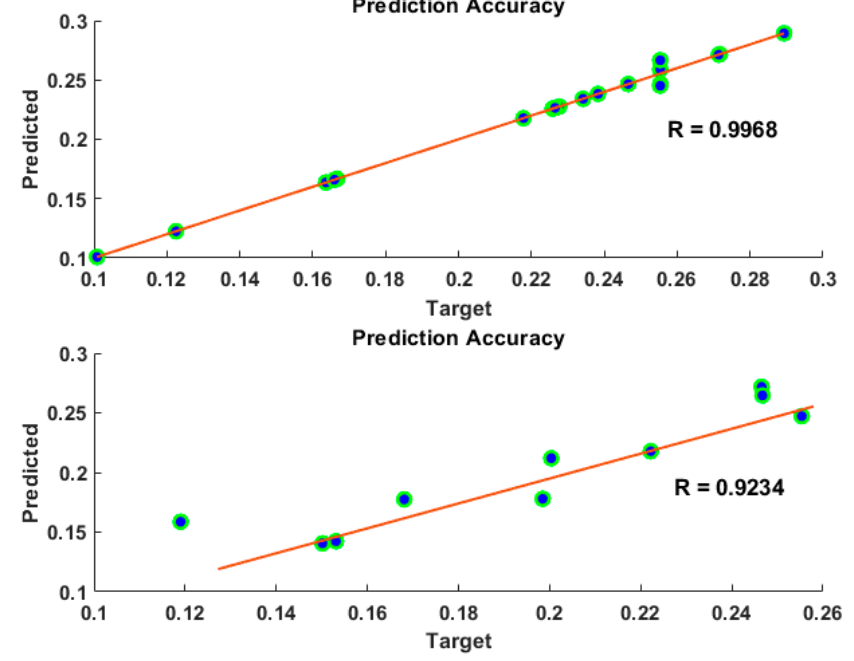
Figure 2. Prediction accuracy for training data ( above ) and testing data ( below